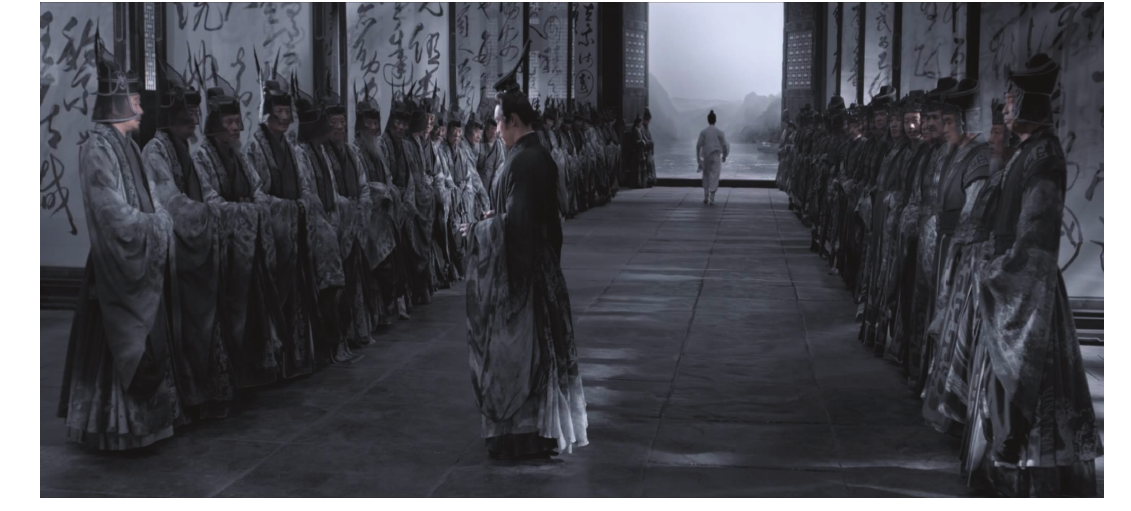
Figure 7. Film still of the palace of Pei Kingdom, from Shadow (Source: Blu-ray distributed by Universal